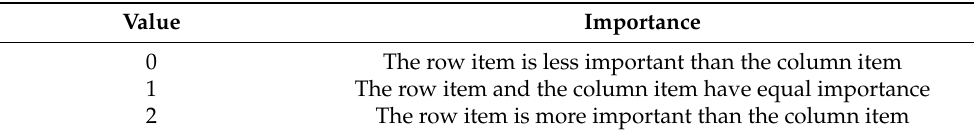
Table 4. Judgments and their value in the importance matrix. Value Importance 0 The row item is less important than the column item 1 The row item and the column item have equal importance 2